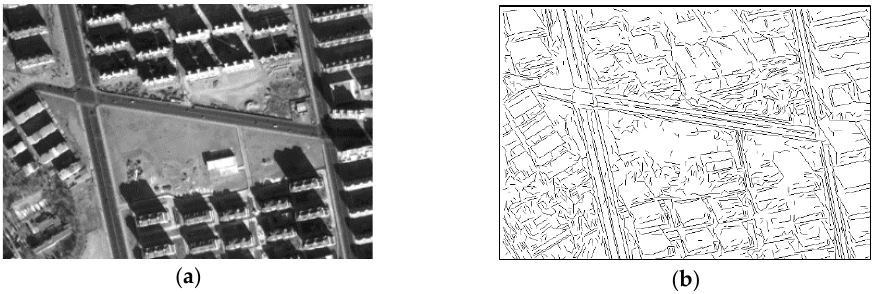
Figure 3. Line extraction result. ( a ) Input image; ( b ) result of line extraction.